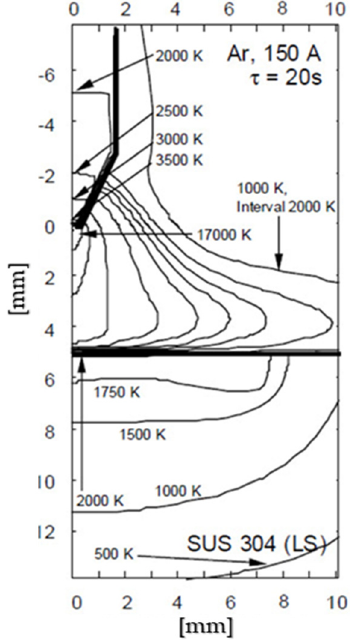
Figure 4. Simulation of the temperature distribution in an argon plasma flame using a tungsten electrode, operating at 150 A for 20 s [19].